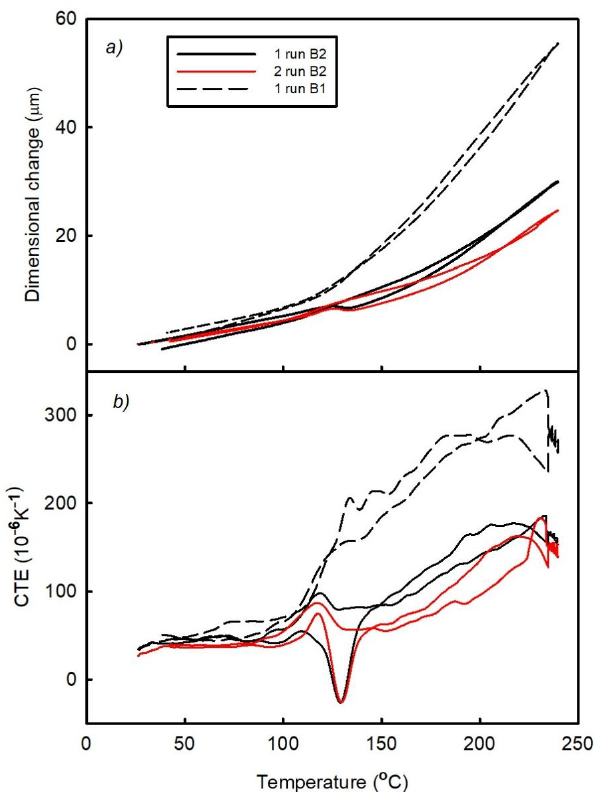
Figure 10. Temperature dependences of the ( a ) dimensional changes and ( b ) CTE of the B2 (FR4 laminate/Cu plated holes) and B1 samples observed after two runs and one run, respectively.